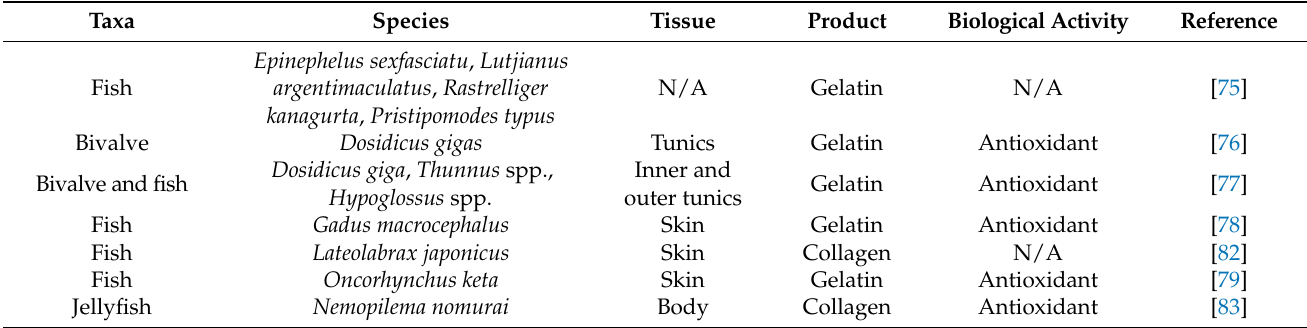
Table 1. Gelatin and collagen from seafood wastes, together with taxa, species and tissue from which they were isolated, and their biotechnological application. N/A refers to “not